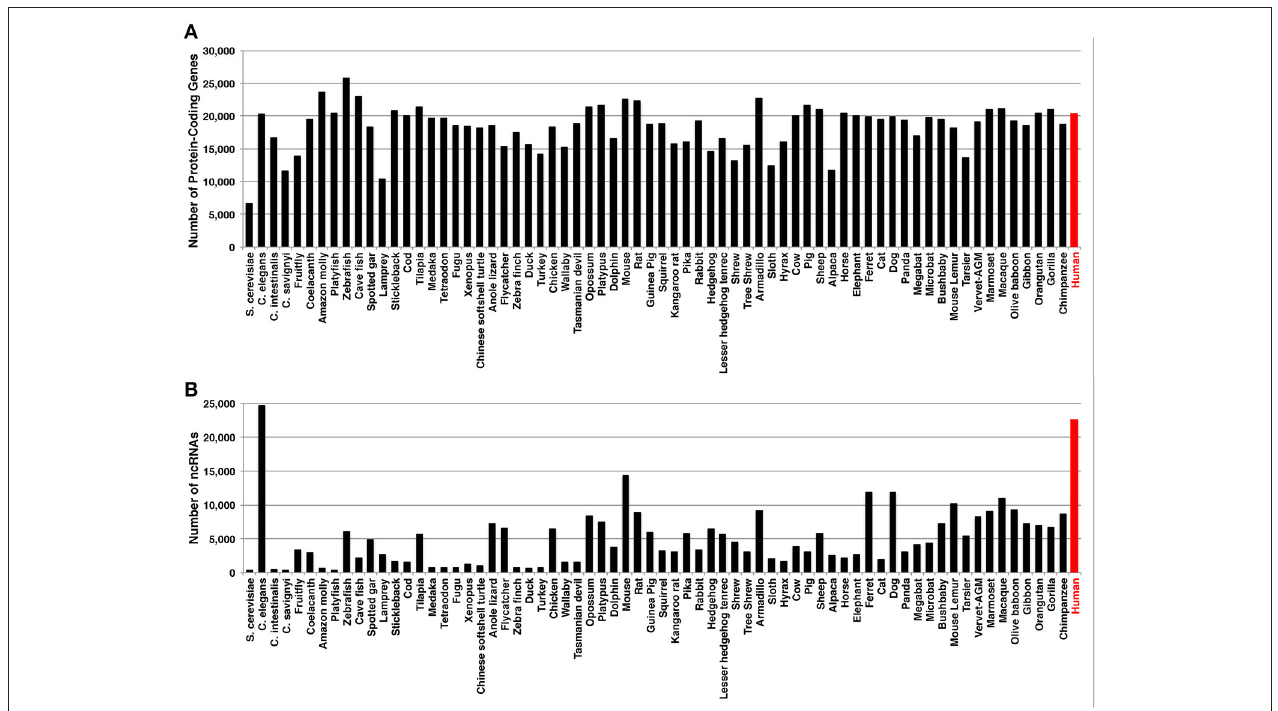
FIGURE 1 | Numbers of (A) protein-coding genes and (B) ncRNAs, including miRNAs and lncRNAs. The information is based on the Ensembl database (Accessed on May 5,